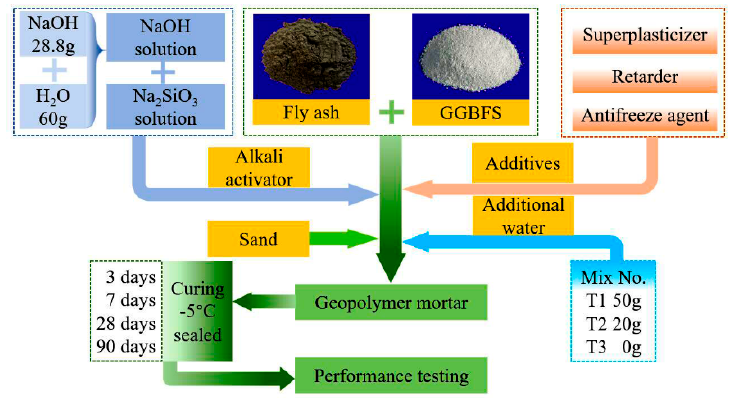
Figure 4. Complete process of samples preparation.